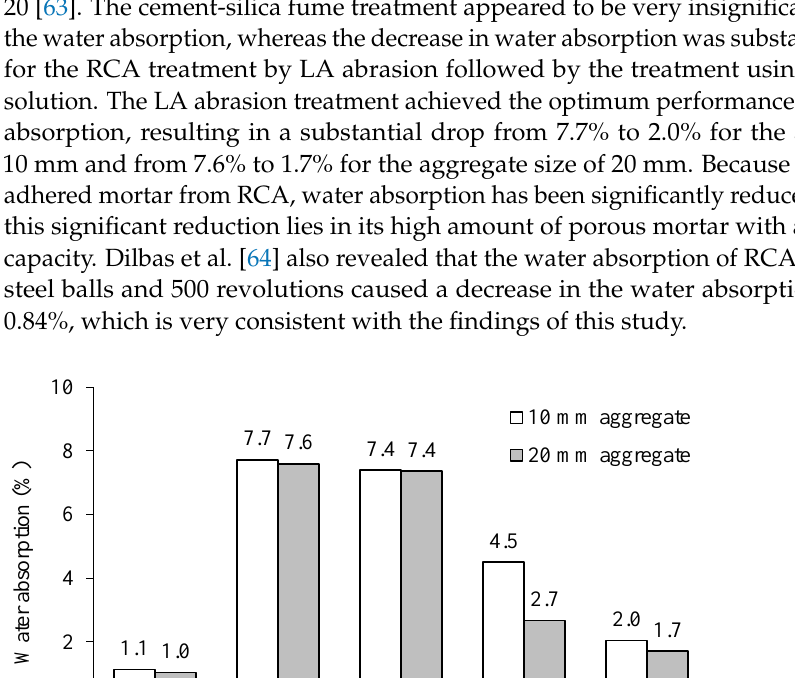
Figure 13. Gain in splitting tensile strength due to the treatment of RCA by different methods (T1, T2, and T3) for: ( a ) 10-mm aggregate; and ( b ) 20-mm aggregate.